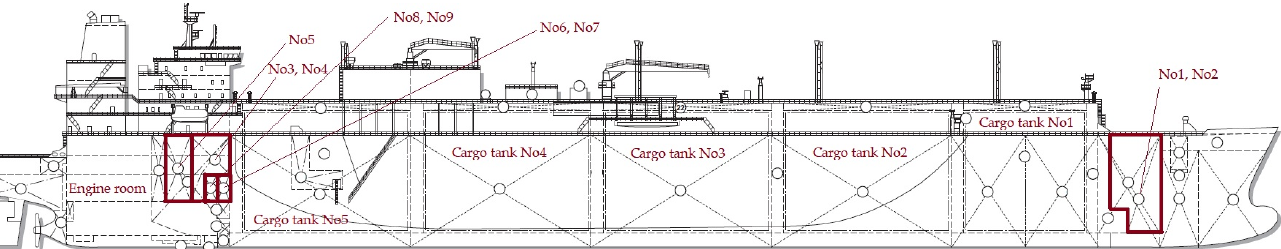
Figure 2. The general arrangement of HFO bunker tank locations on the LNG carrier.